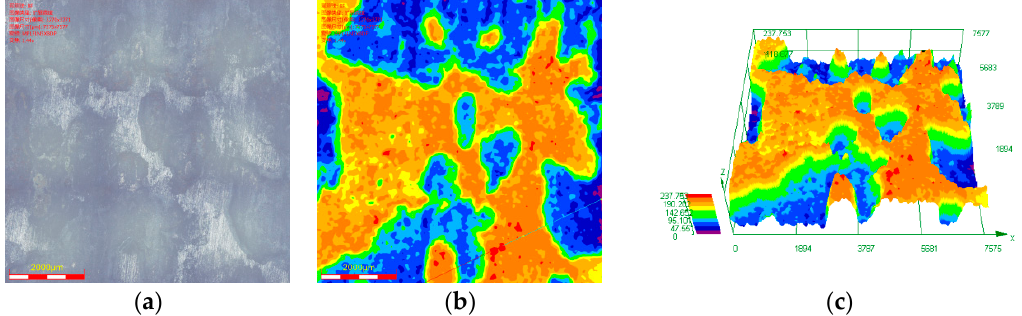
Figure 11. Corrosion depth analysis on cleaned surface of the sample exposed to 30% crude oil/brine condition at Pco 2 = 1.0 MPa and 65 °C: ( a ) corrosion morphology; ( b ) corrosion depth distribution contour diagram; and ( c ) corrosion depth distribution 3D diagram.